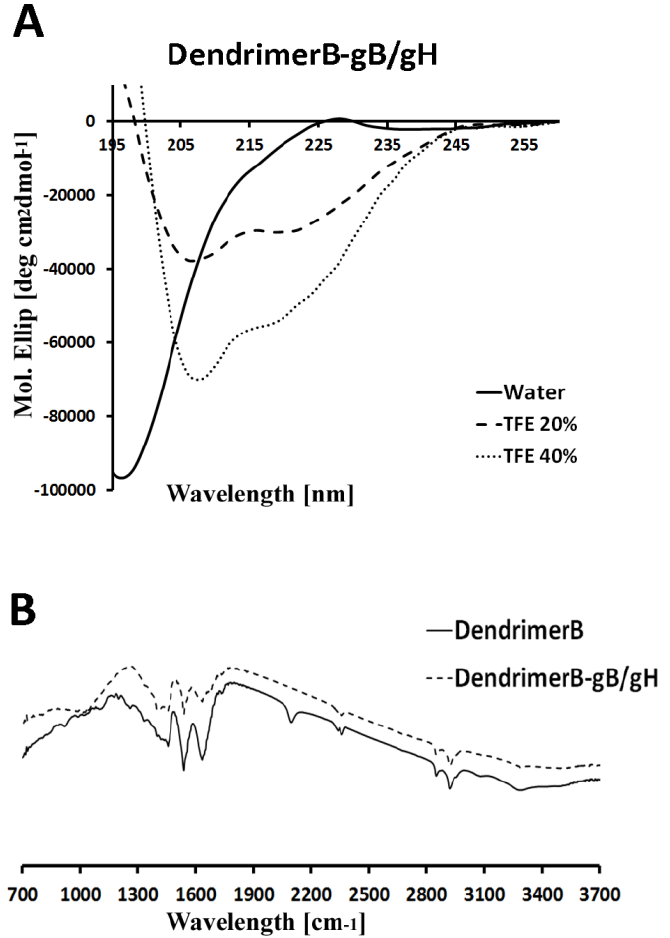
Figure 3. Circular dichroism of DendrimerB + gB/gH in water with different percentage of TFE (panel A ) and IR spectroscopic analysis of DendrimerB and DendrimerB + gB/gH (panel B ).